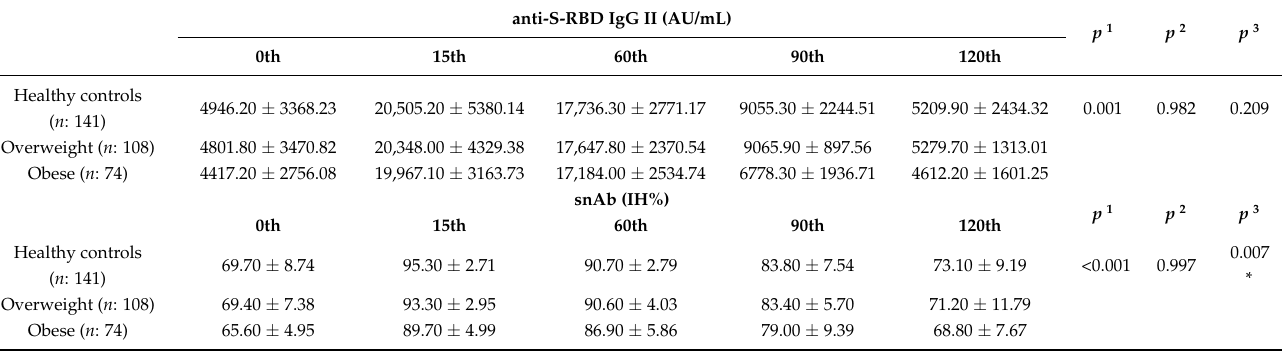
Table 2. Distribution of anti-S-RBD IgG and snAb IH% levels in all participants before (day 0) and after (days 15, 60, 90, and 120) the third vaccine dose (Mean ± SD). anti-S-RBD IgG II